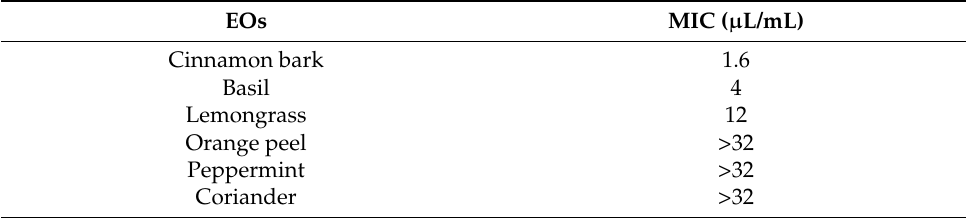
Table 5. Minimum inhibitory concentration (MIC) of EOs against C. acutatum